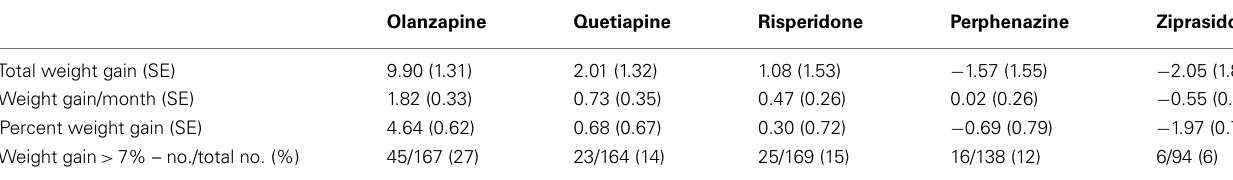
Table 2A |Weight measures without adjusting for covariates.